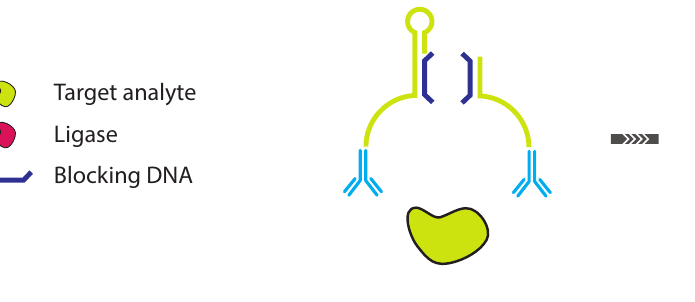
Figure 11. A schematic overview of the BINDA assay, an alternative format of